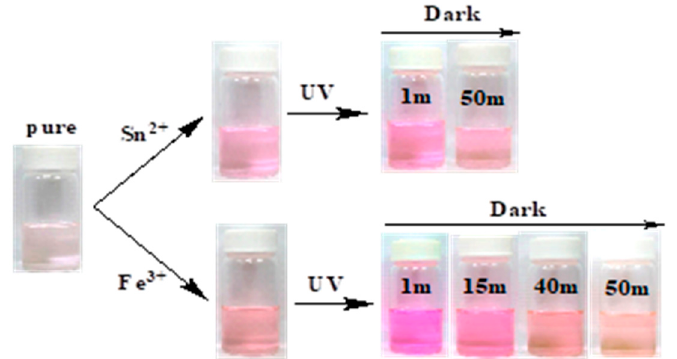
Table 2. Quantum efficiency ( Φ F , %) of R–PLG 23 and R–PLG 13 in solution mixtures of DMF/ether and